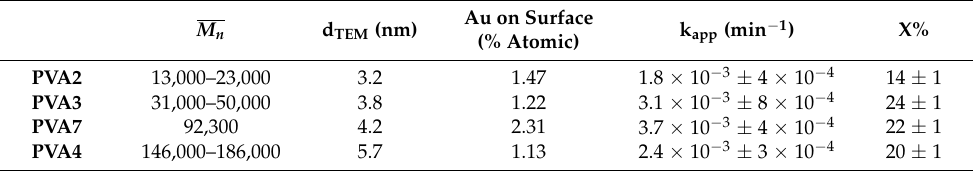
Table 7. Values of the apparent constant and conversion for pseudo-first-order reactions using PVA with different molecular